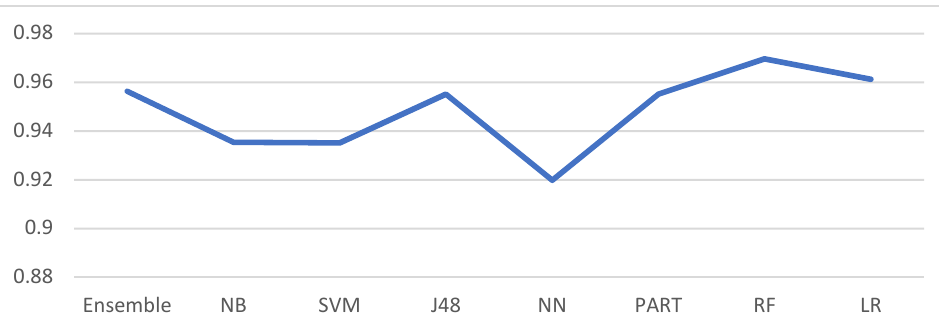
Figure 4. Prevalence of disease against genders. 4.2. Water Source and Quality Water is a fundamental source of life needed everywhere in the world. To better un- derstand the hygienic conditions of patients, the study considered sources and quality of water used by different patient’s age groups through box plot data analysis. Table 7 illus- trates the consumption of different water sources for different purposes and in different quantities by different patients’ age ranges. First, considering the drinking water category, we see that most of the patient’s used tube well (78.5%) water for drinking purposes be- tween the ages of 1 year (infants) to 70 years (senior citizens). If we consider the outliers,